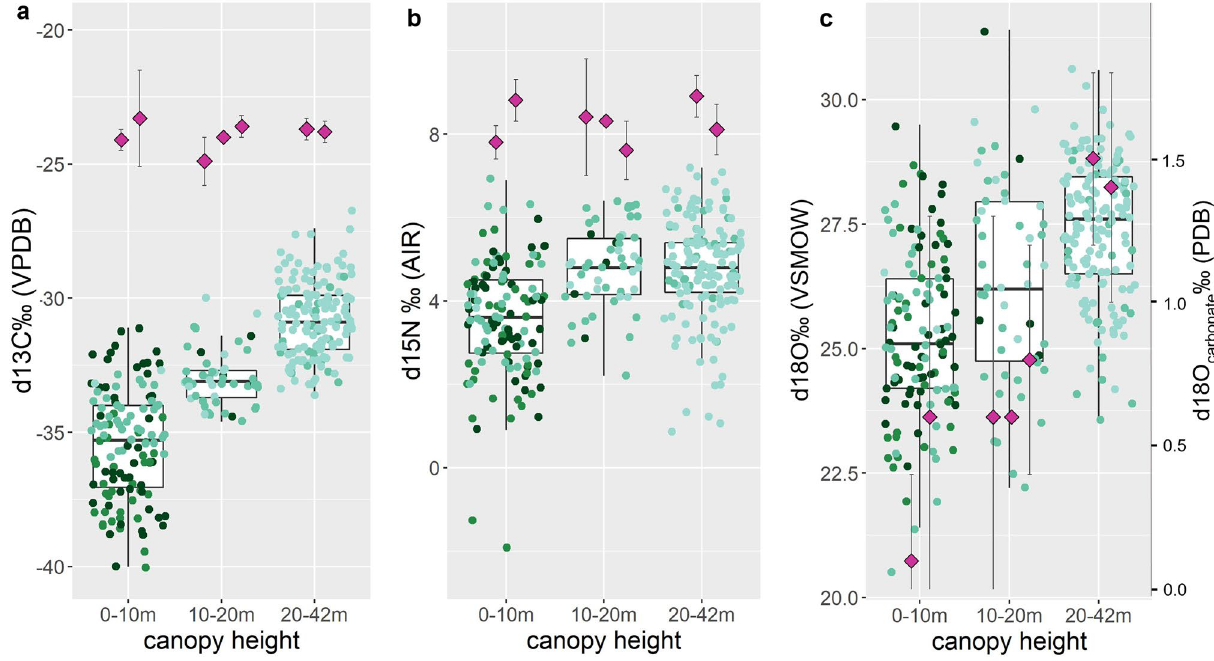
Figure 4. Whisker plots showing the distribution of ( a ) δ 13 C, ( c ) δ 15 N, and ( b ) δ 18 O values in leaves of different plant types (legends Figs. 1, 2, 3) across the canopy strata occupied by arboreal primate species at Taï forest. Average primate isotope data from bone collagen ( a , b ) and carbonate ( c ) are shown by canopy strata use as pink diamonds (± 1σ SD). The low canopy is most used by the taxa Cercocebus atys and Cercopithecus campelli , mid canopy is most relevant for C. petaurista , C. diana and Procolobus verus , whereas high canopy levels are inhabited by Procolobus badius and Colobus polykomos 37 . Vertical niche differentiation is best reflected by δ 18 se (Figs. 2c, 4b). Our understanding so far is that δ 15 N values in plants are highly dependent on the δ 15 N ratios of the source soil as well as any symbiotic associations rather than height or hydraulic limitations 51 . Ometto and colleagues 8 found slight, but significantly lower understory δ 15 N values compared to the higher forest layers in two out of four sites measured in the Amazon, suggesting this may be related to different nitrogen sources in the soil, e.g. through the higher uptake of NO 3 by understory vegetation. Height also affected δ 15 N values in epiphytes but was assumed to be associated to fractionation during nitrogen acquisition and mycorrhizal asso- ciations and possibly also related to water stress 16 . As in our study height was not a driving factor in leaf δ 15 N variation, we assume that PAR related evaporation stress may partly explain the fractionation of δ 15 N in leaves, and less so nitrogen source. Low levels of light in the understory have profound impacts on light acquisition morphology of “shade leaves”, which tend to have higher levels of chlorophyll, and larger, thinner leaves to improve light capturing efficiency 21,52 . We found a significant correlation between leaf LMA and height (Fig. 3d), as well as significant variation in LMA between plant species (Fig. 2d). Leaves of vines and understory plants had consistently lower LMA measures compared to emergent and midcanopy trees. Emergent and midcanopy trees will experience higher degrees of water stress due to gravity and evaporation, especially in the upper canopy, and will adjust their leaf physiology to conserve water loss. However, vines and understory plants experience less water stress and may be less likely to grow leaves suited for water conservation 21 . The relationship between leaf toughness and height has implications for primate food preference as primates can be assumed to select for high energy yields which involve the least handling and masticatory investment 53 . Thus, primates may prefer leaves with low LMA in the lower canopy, which are thinner, presumably less tough and hence require less mastication energy over high canopy leaves 30 . High canopy leaves or “sun leaves” are expected to have higher toughness and require higher energy usage to consume 30,54 . In their 2008 study, Onoda and colleagues measured leaf toughness as a product of LMA and “punch strength” or maximum force/area and found that the toughness of sun leaves was mainly determined by their high LMA. The correlation we found between height, PAR and LMA in leaves from Taï forest makes LMA an interesting parameter for future work on the canopy effect and primate isotope ecology. We also found a highly significant negative correlation between LMA and %N (Table 2) in our leaf samples. Low light leaves invest more nitrogen into light harvesting pigments, such as chlorophyll, for greater light cap- turing efficiency 28 . Alternatively, leaves in the upper canopy experience light-saturated rates of photosynthesis and will invest in enzymes associated with carbon fixation, mainly rubisco, to enhance their photosynthetic capacity 21 . Hence, our findings also suggest that leaf %N varies indirectly with height, which may affect primate feeding behavior. Primates are thought to prefer leaves with high protein content 55 . Since fruits are low in protein, primates not obtaining protein from invertebrate or vertebrate foods, will rely on leaves for a large portion of the protein in their diet and may preferentially select foliage high in nitrogen 56,57 . While this variation in %N is